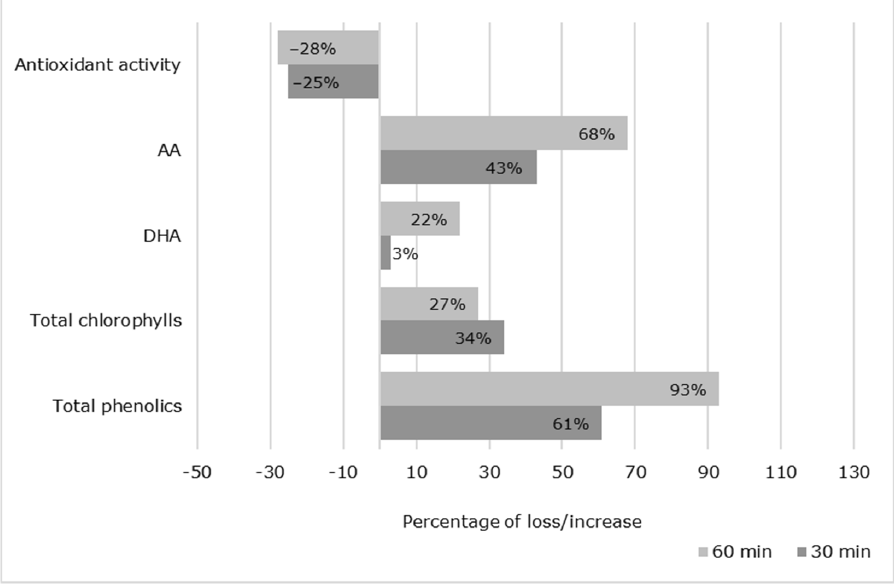
Figure 3. Bioactive compounds and antioxidant activity changes (in percentages) after ozone treatments. AA: ascorbic acid; DHA: dehydroascorbic acid. ments. AA: ascorbic acid; DHA: dehydroascorbic